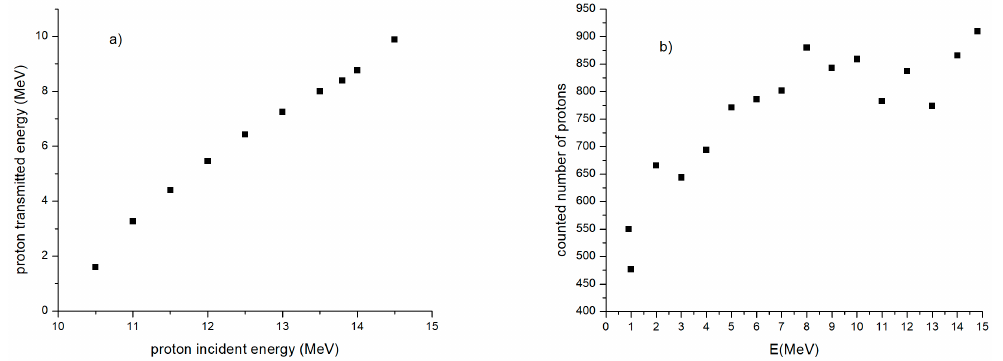
Figure 6. ( a ) Dependence of proton transmitted energy through 1 mm thick CR-39 detector on incident proton energy within the 10–15 MeV range; ( b ) Counted number of protons stopped in 2 mm CR-39 detector as function of incident proton energy .